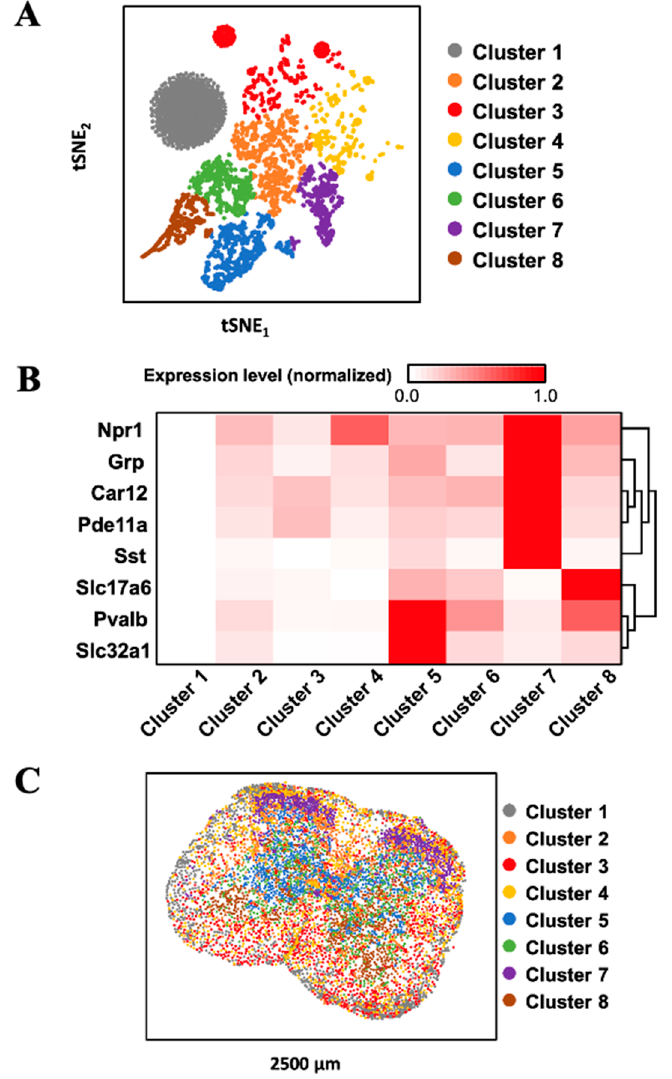
Figure 6. ( A ) Based on their mRNA expression patterns, the cells in a fixed frozen mouse spinal cord tissue are partitioned into 8 clusters. ( B ) The mRNA expression patterns in the different cell clusters. ( C ) Anatomical locations of the individual cells from the distinct clusters in the spinal cord tissue.